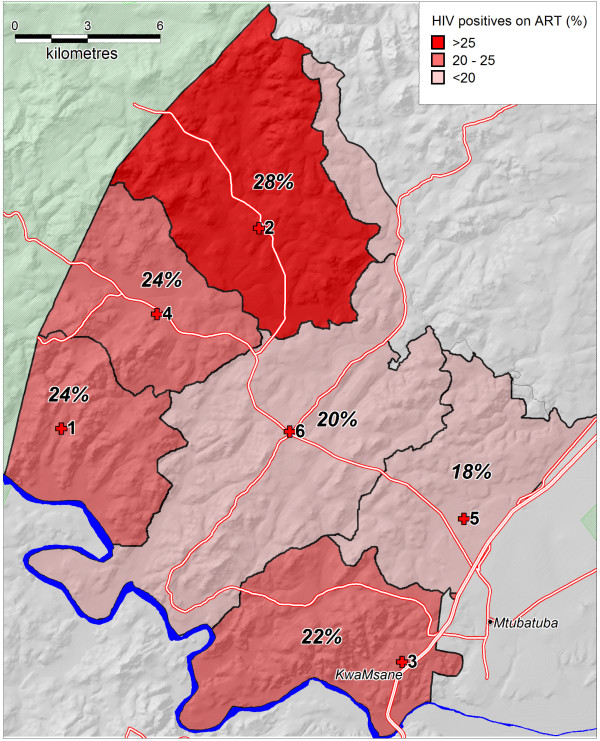
Mean uptake of antiretroviral treatment (%) by HIV positive adults in adjacent clinic catchment areas.